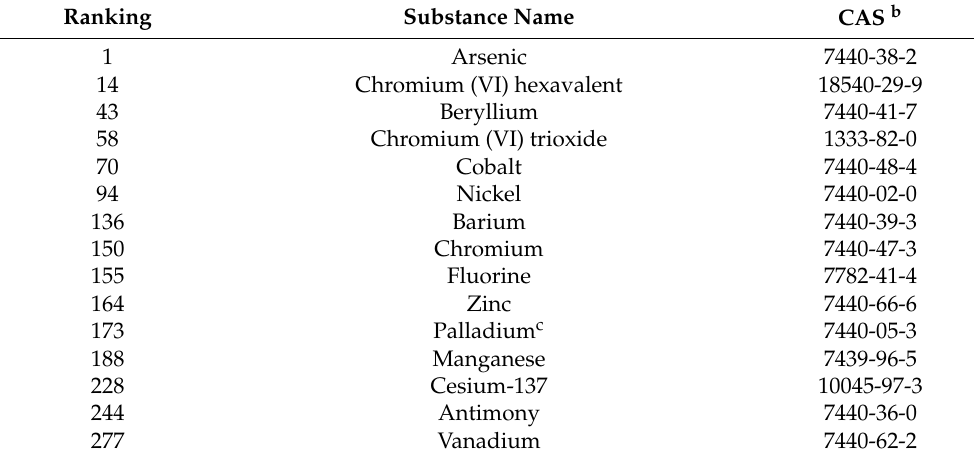
Table A2. Critical Element forms listed on the 2019 Agency for Toxic. Substances and Disease Registry Substance Priority List a